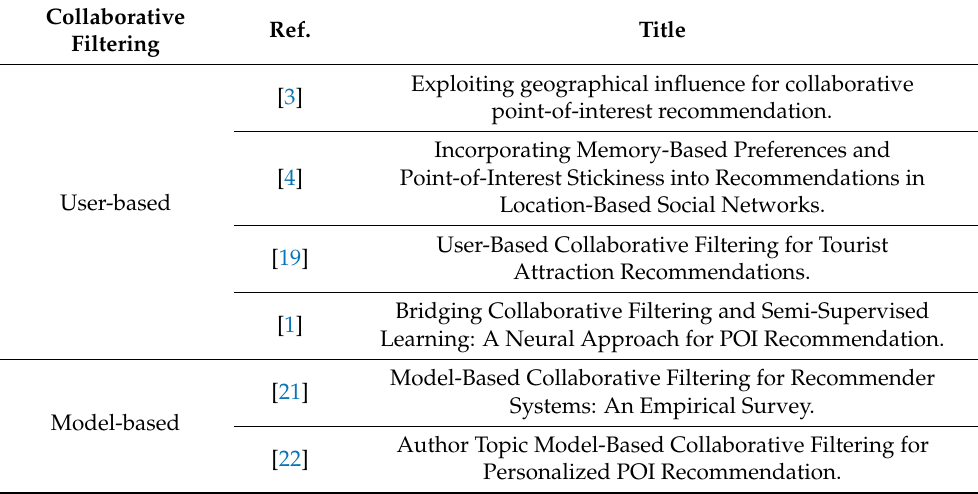
Table 2. Summary of previous studies on collaborative filtering (CF)-based POI recommendation.